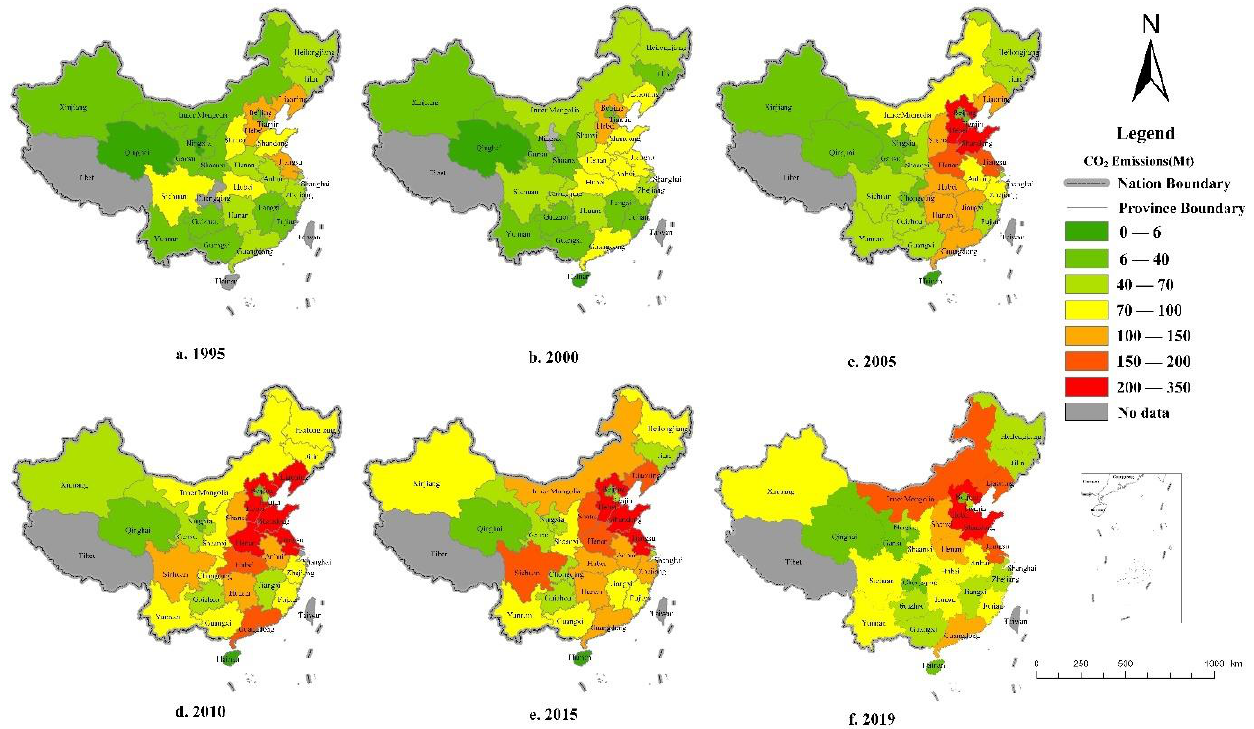
Figure 2. Industrial CO 2 emissions at the provincial level during 1995 – 2019.